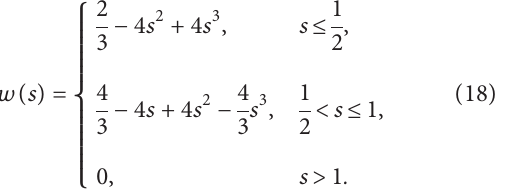
Figure 1: Shape functions at different